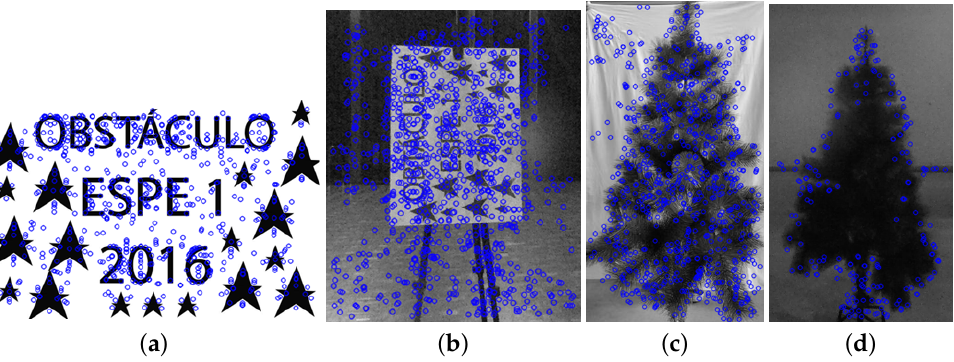
Figure 1. Feature point detection. ( a ) Pre-designed obstacle, on the database; ( b ) Pre-designed obstacle, captured by the Unmanned Aerial Vehicle (MAV); ( c ) Obstacle present in the environment, on the database; ( d ) Obstacle present in the environment, captured by the